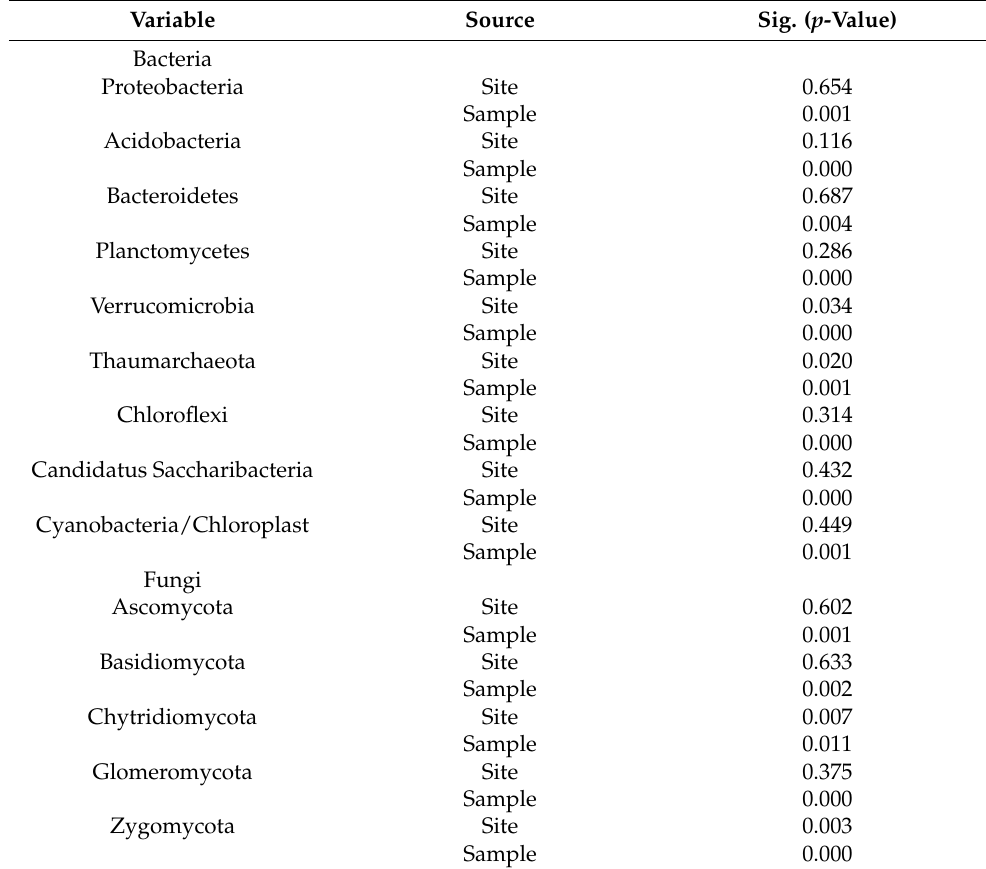
Table 1. Probability ( p -value) that taxa at phylum level can belong to the same population comparing Sites (Albarella and Caleri) or Samples (10 samples in each site, taken 2 by